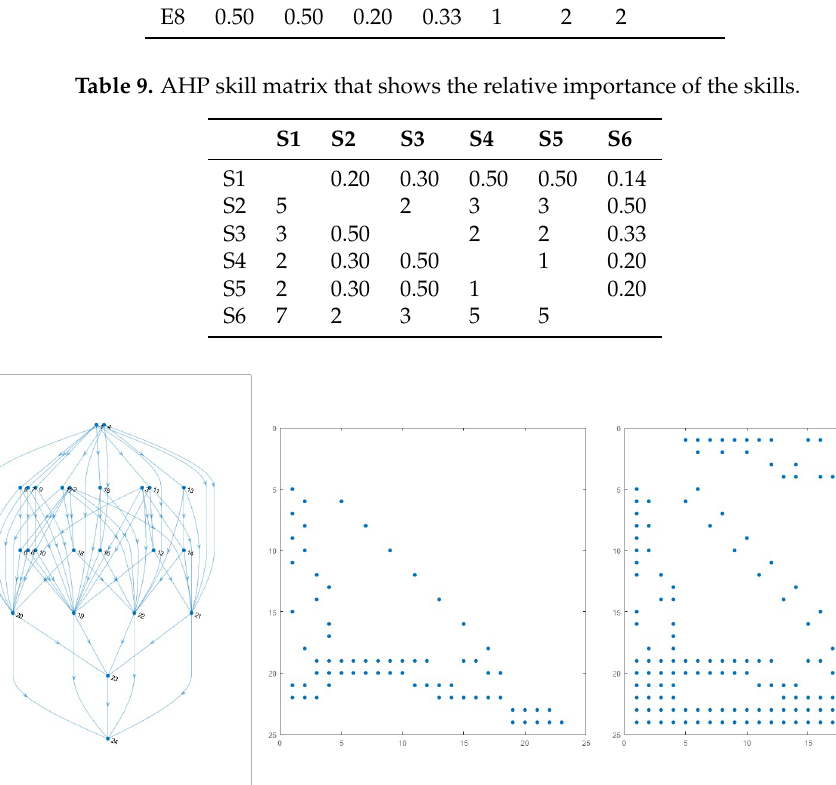
Figure 7. Possible path ( left ), precedence ( middle ) and transitive closure ( right ) of the activities (the unmarked pairs are